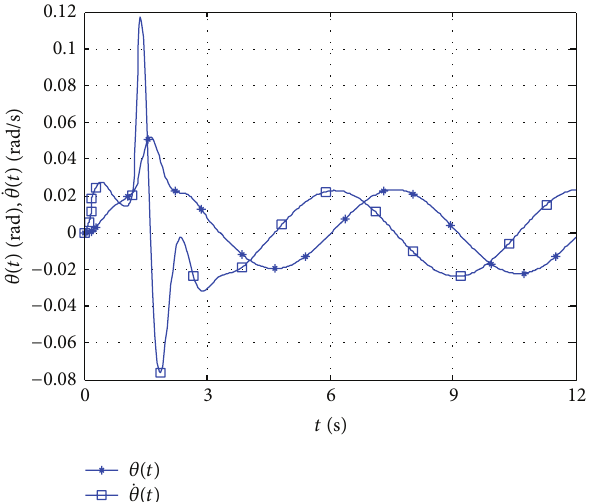
Figure 9: Pitch motions of the tensegrity-based water wave energy harvester.